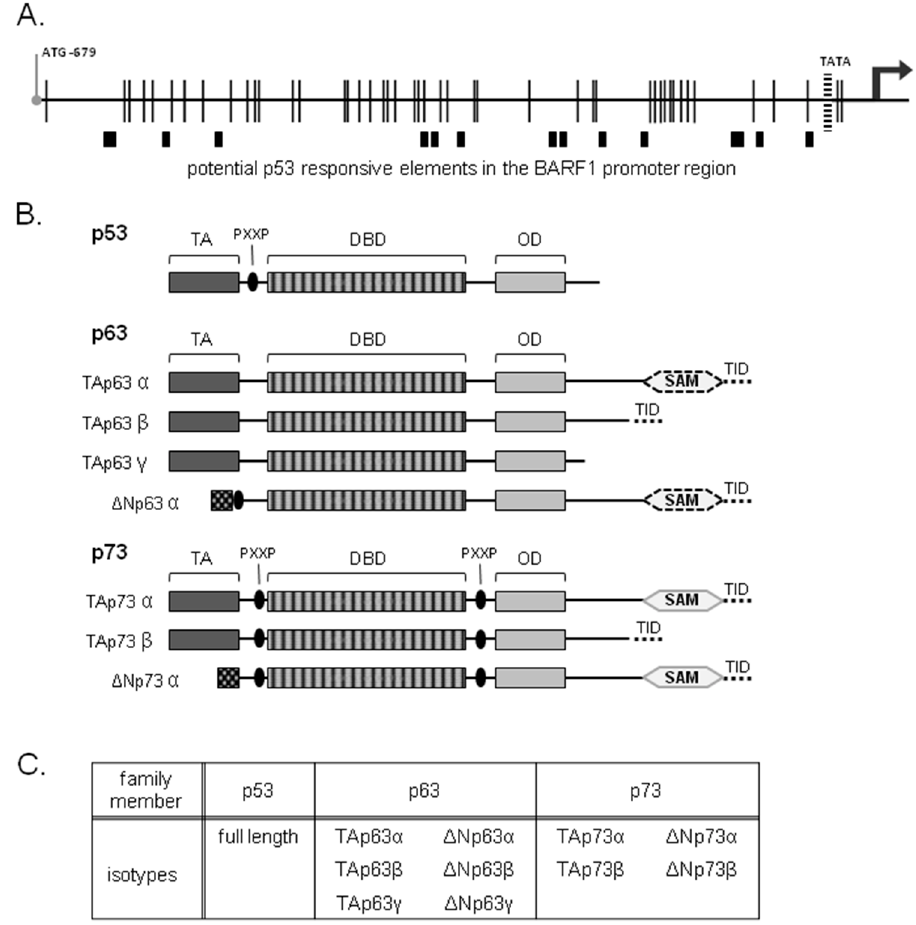
Figure 1. The p53 family of transcription factors and potential binding sites in the BARF1 promoter region. ( A ) Schematic overview of p53 family proteins. Transactivating domain (TA); DNA binding